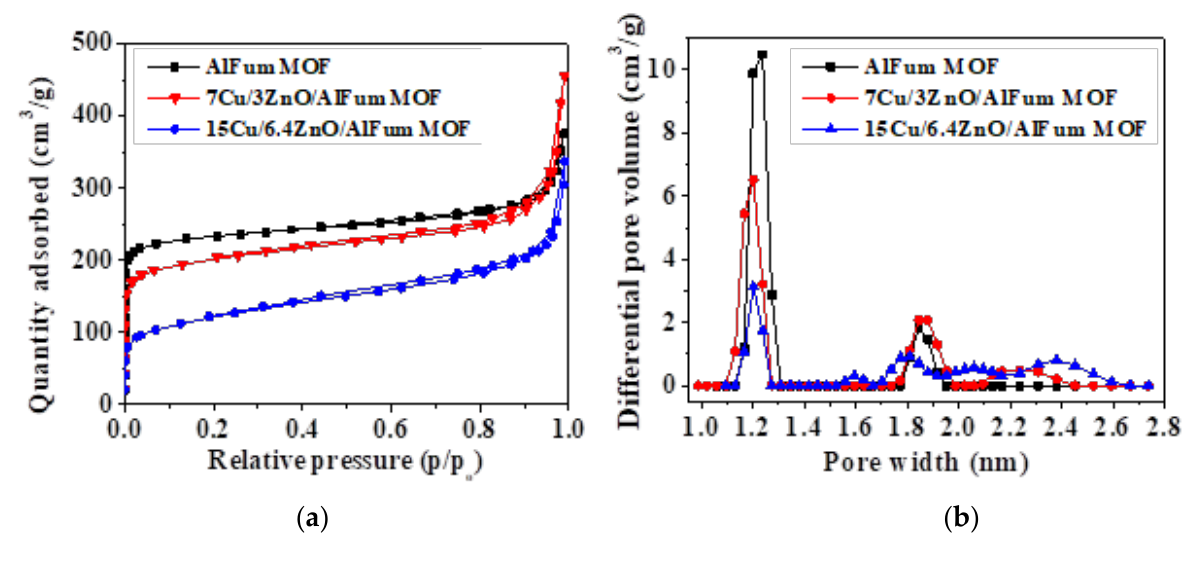
Figure 2. N 2 sorption isotherms at 77 K of: ( a ) AlFum MOF, 7Cu/3ZnO/AlFum MOF, 15Cu/6.4ZnO/AlFum MOF; and ( b ) NLDFT pore size distributions of AlFum MOF, 7Cu/6.4ZnO/AlFum MOF, and 15Cu/6.4ZnO/AlFum MOF. Table 1. S BET , pore volume, mean pore size diameter, and elemental composition of pristine AlFum MOF and Cu/ZnO/AlFum MOF